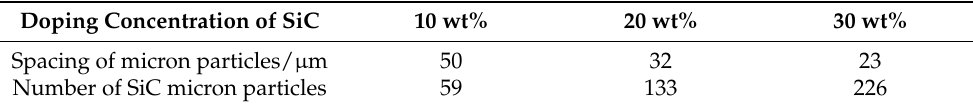
Figure 4. Different SiC doped EP/SiC composite models. ( a ) 10 wt% SiC; ( b ) 20 wt% SiC; ( c ) 30 wt% SiC. Table 5. The number and spacing of SiC particles in the micro dielectric model with the different filling amounts.